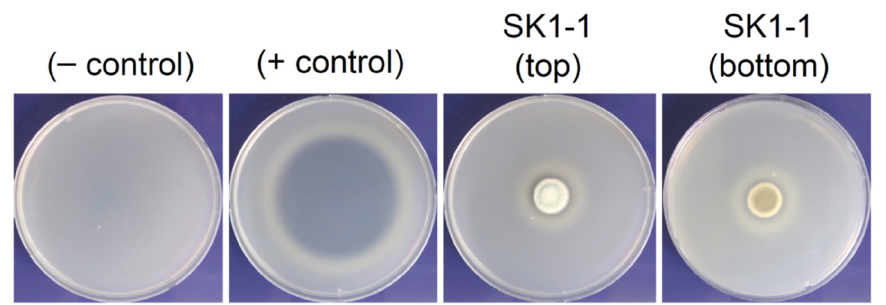
Figure 3. Skim milk agar assay for proteolytic activity of SK1-1. Skim milk (1%, w / v ) was used as a substrate for protease. Sterile H 2 O and proteinase K were included as negative ( − ) and positive (+) controls, respectively. SK1-1 conidia were inoculated on skim milk agar, followed by incubation at 28 °C for 7 days. Proteolytic activity was determined by the presence of clear zones surrounding the colonies.